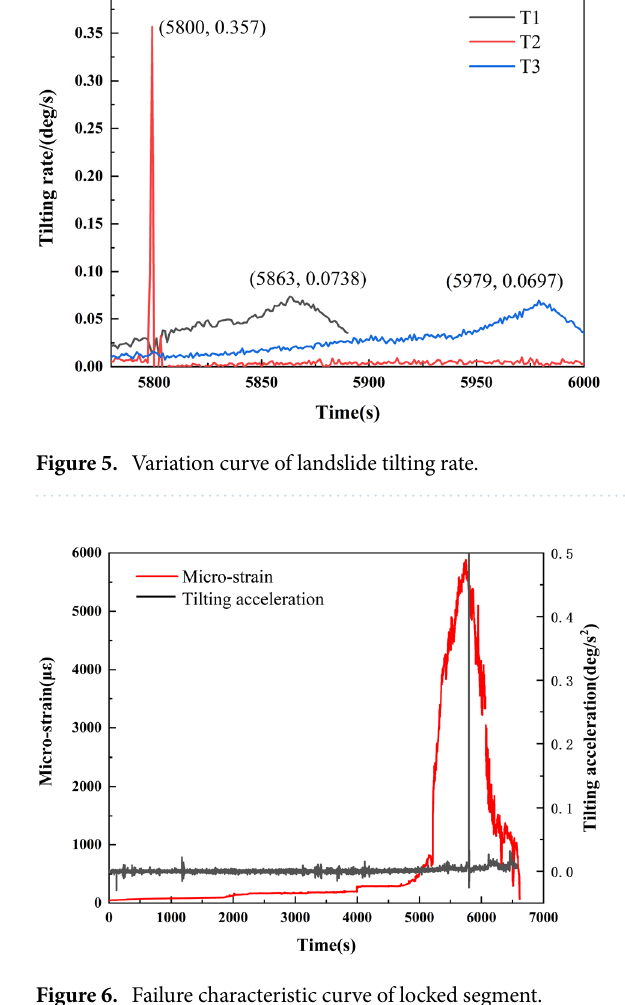
Figure 6. Failure characteristic curve of locked